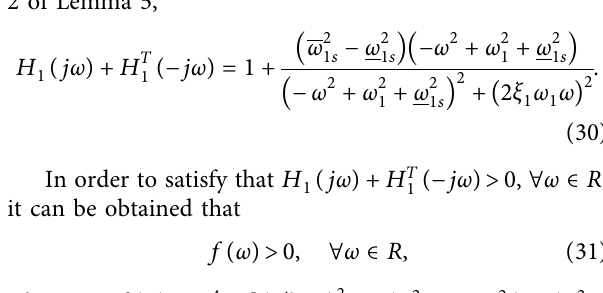
Figure 2: A 1-DOF model with a